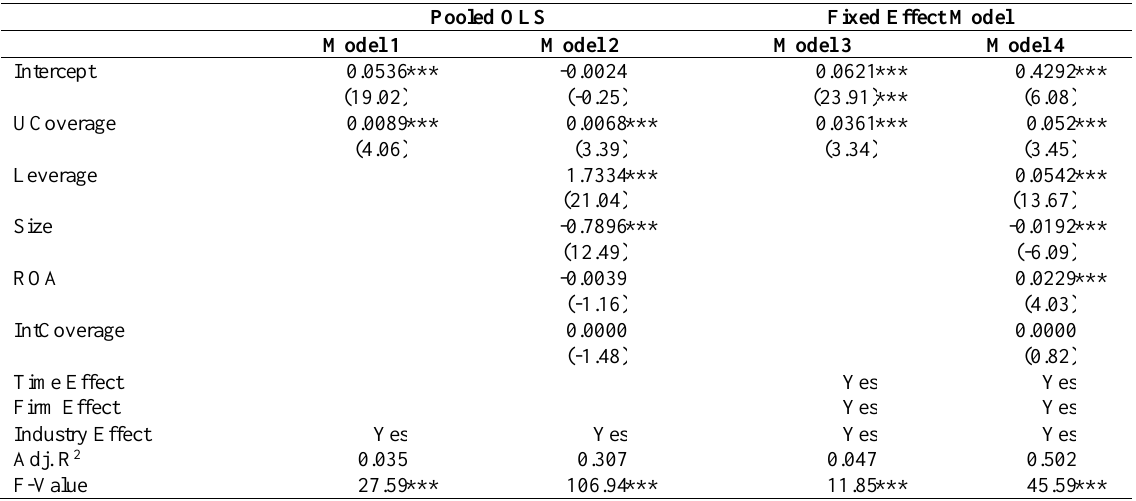
Table 5: Test results on hypothesis 1 for debt cost by using union coverage Pooled